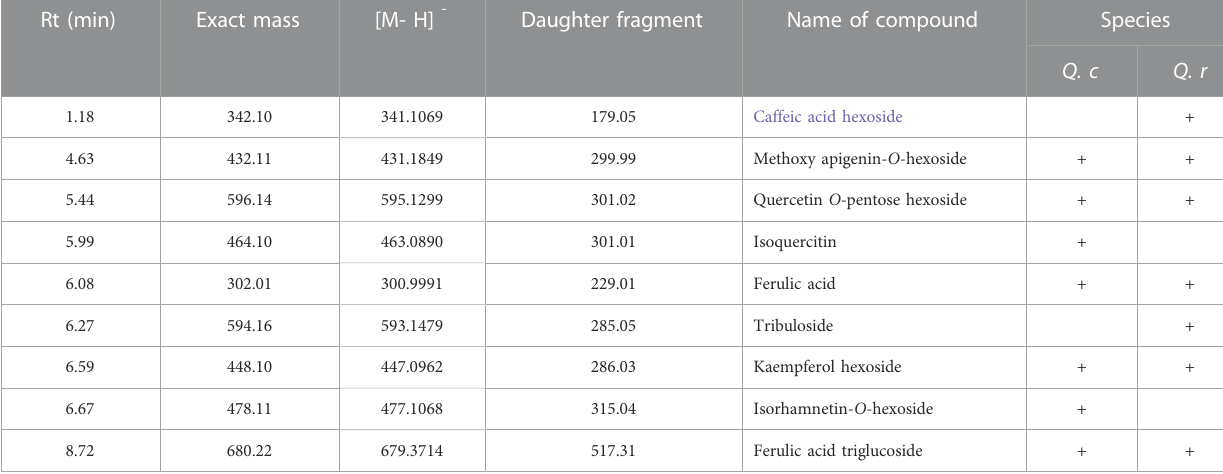
TABLE 2 MS/MS fragmentation for the major compounds present in Q. coccinea and Q. robur leaves 80% aqueous methanol extract. Rt (min) Exact mass [M- H]